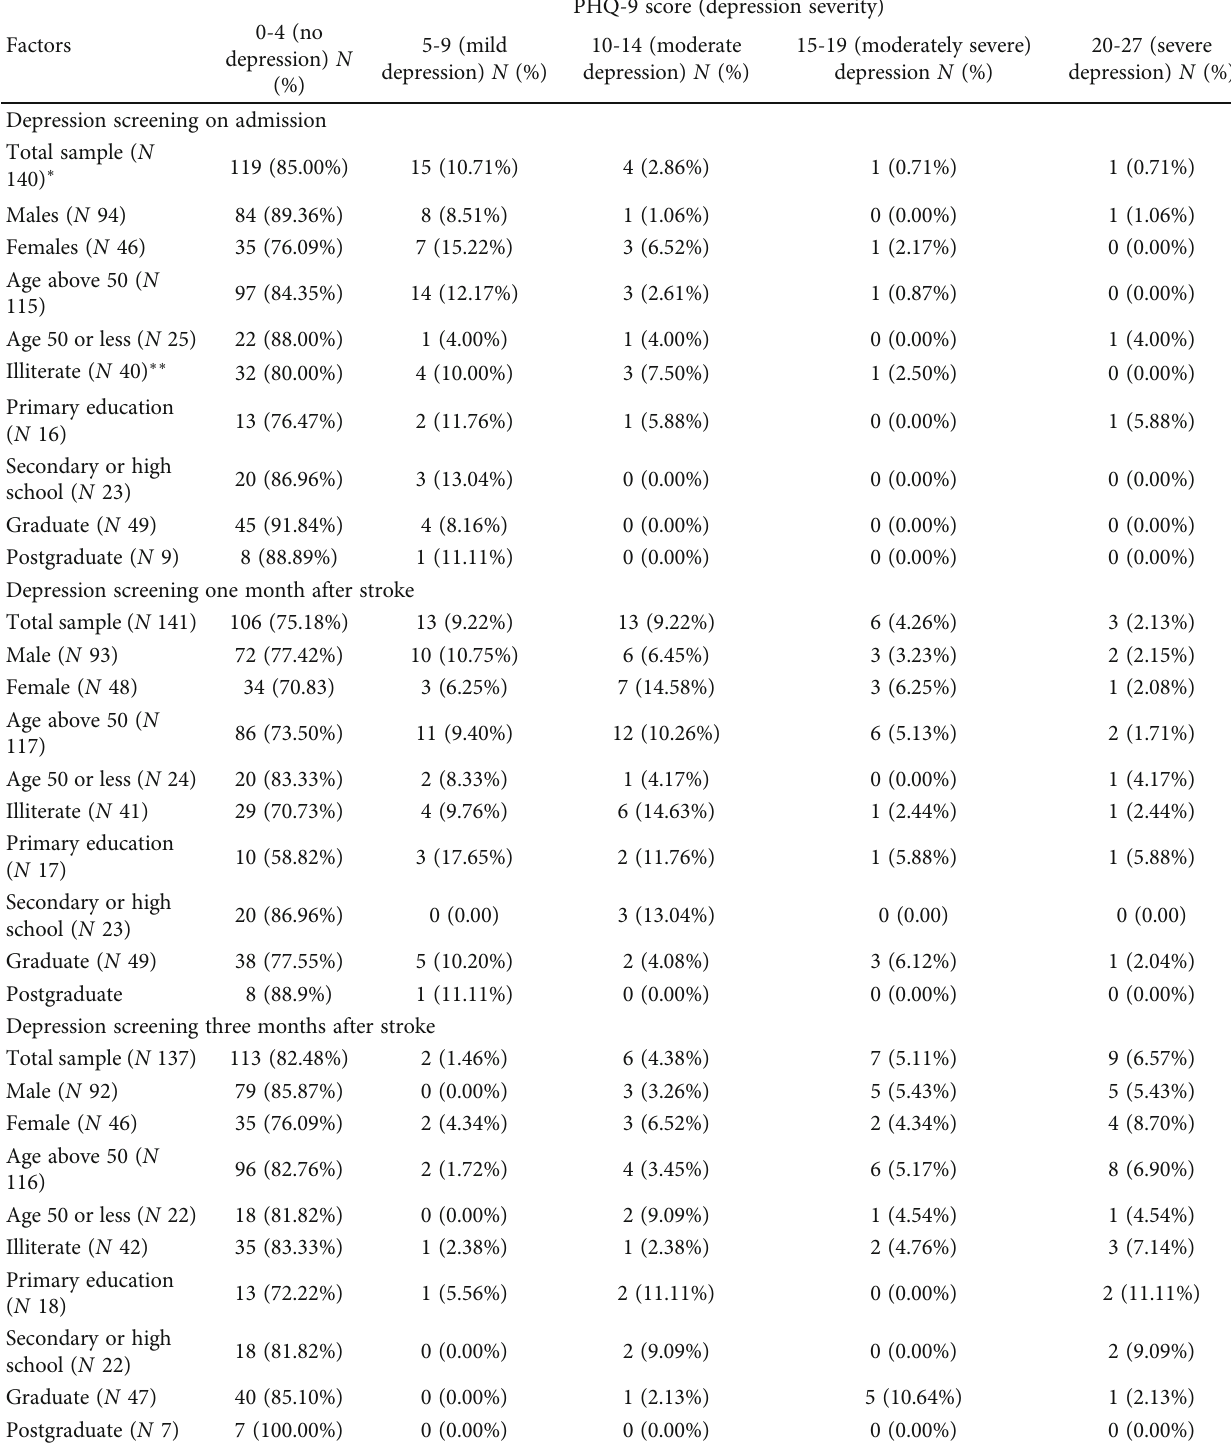
Table 4: Prevalence of